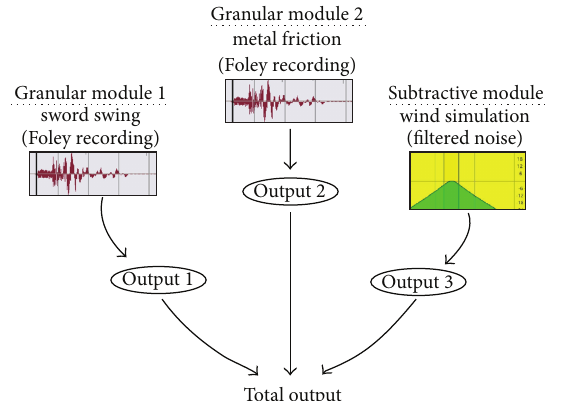
Figure 4: Illustration of the design of the swing swoosh sounds of the sword, combining granular synthesis with subtractive synthesis.